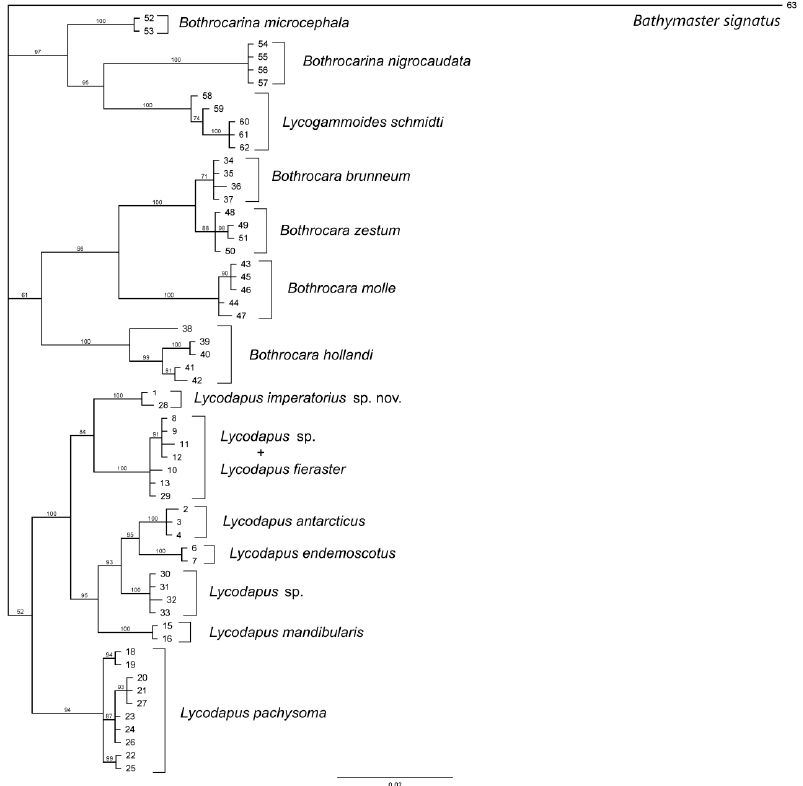
Figure 2. Tree topology reconstruction of specimens of Lycodapus imperatorius sp. nov, its congeners, sister group, and outgroup based on the Bayesian Inference Substitution Model HKY85; 1,100,000 chain length; and 100,000 burn-in-length for mitochondrial cytochrome oxidase subunit I ( COI ) genes. Numbers beside each branch indicate bootstrap values. Numbers to the right of the branches correspond to the number of specimens in Table 1.